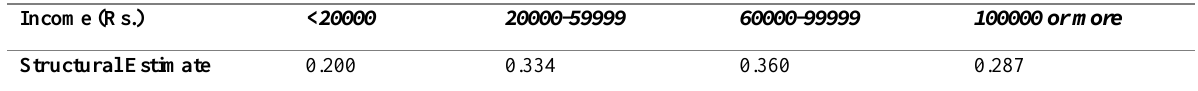
Table 12: Regression weights of the relationship among education level, return process experience post-purchase regret at shopping malls in Sri Lanka Income (Rs.) <20000 20000-59999 60000-99999 100000 or more Structural Estimate 0.200 0.334 0.360